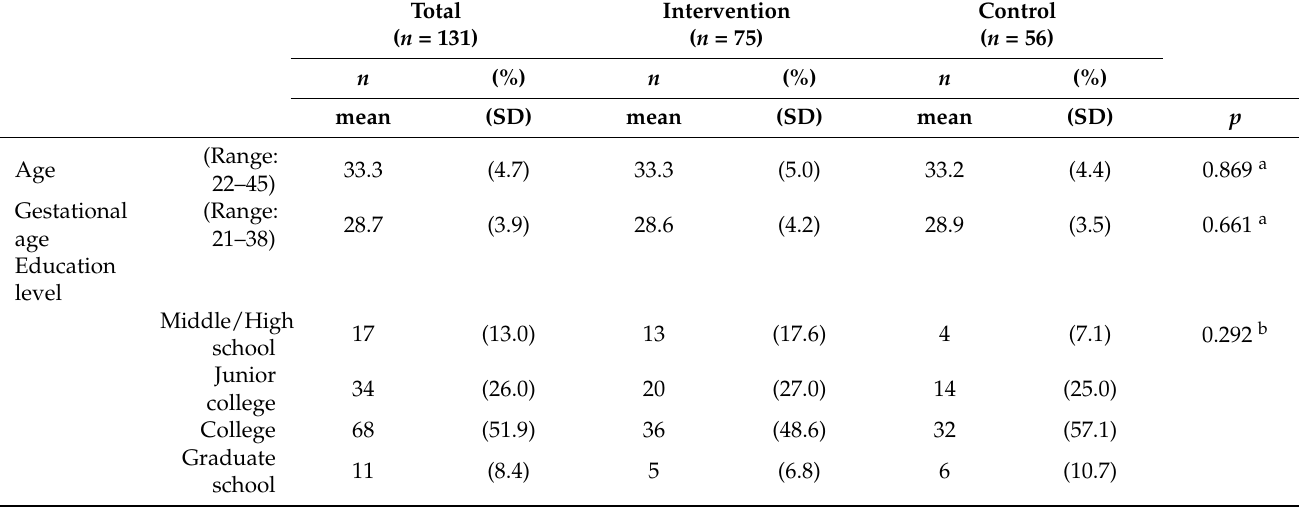
Table 3. Baseline characteristics of study participants ( n = 131).